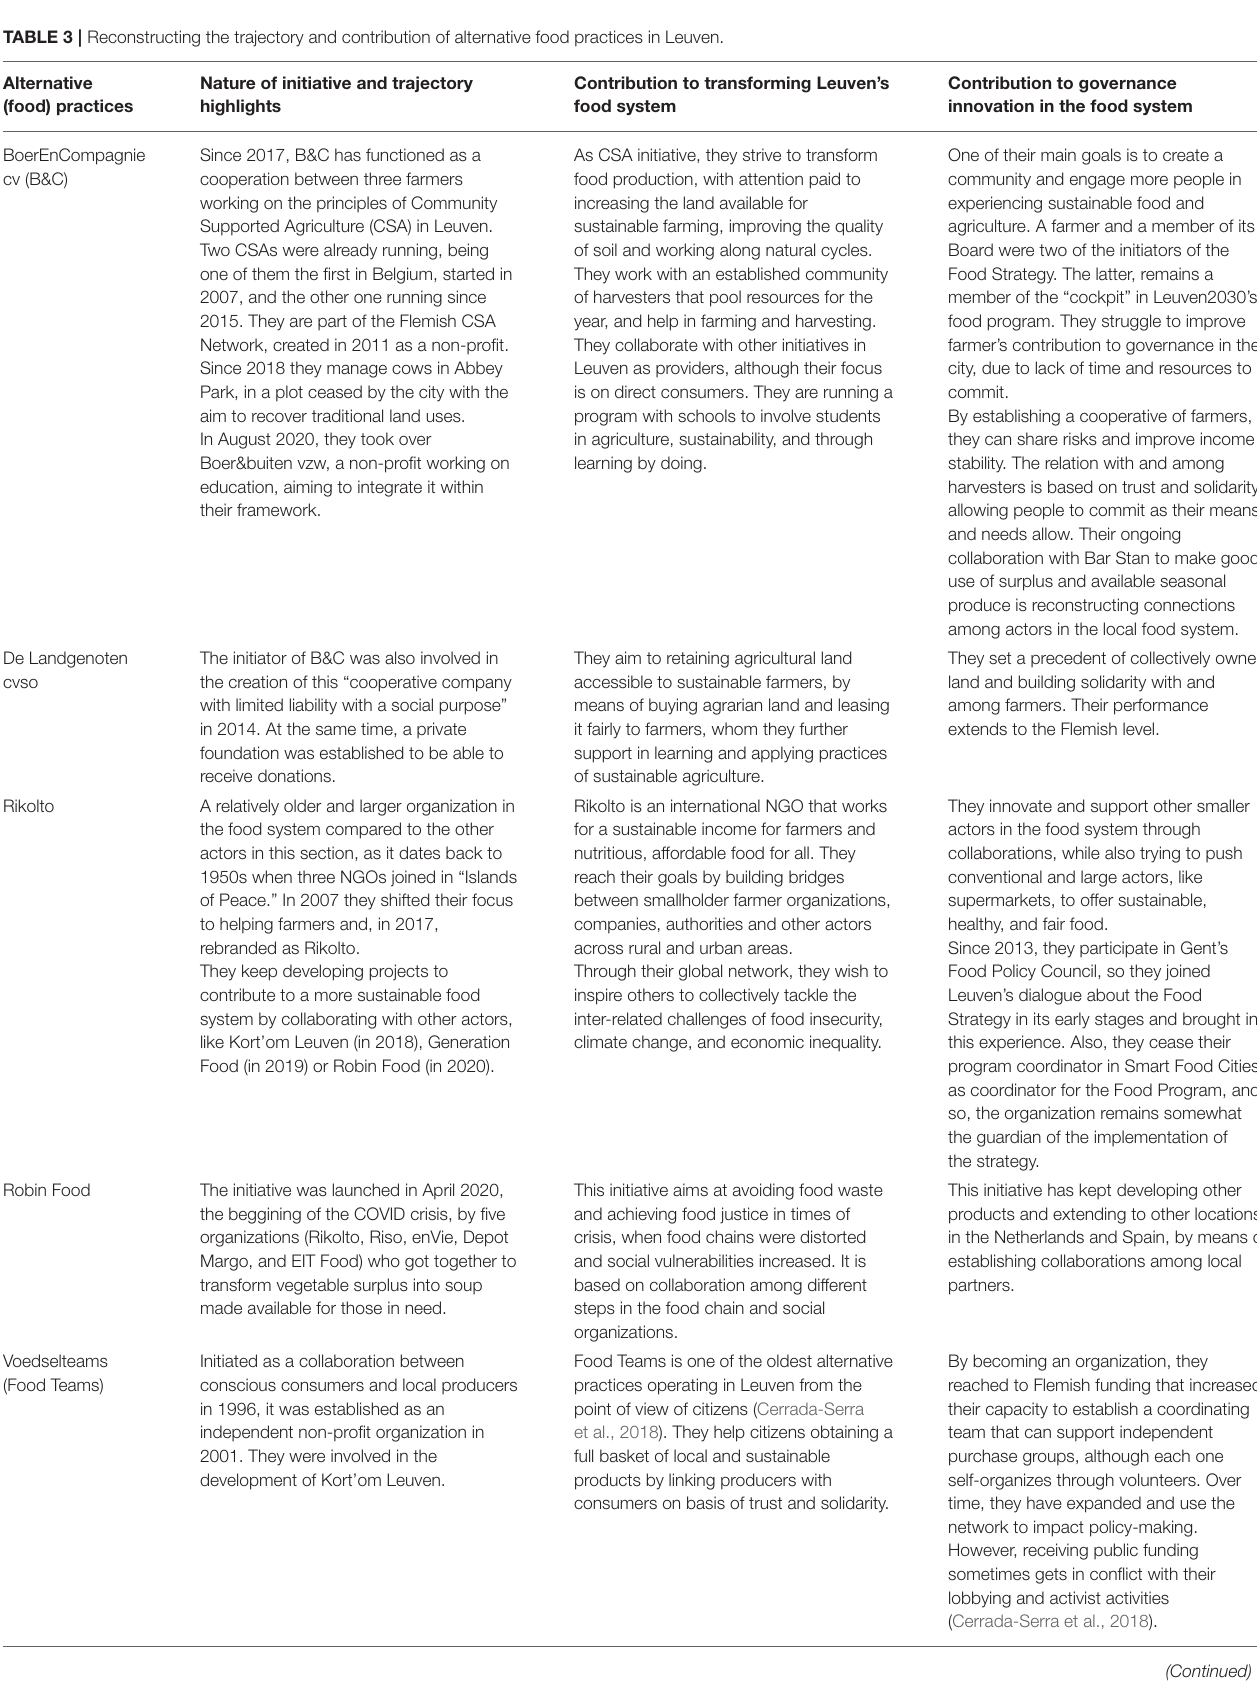
TABLE 3 | Reconstructing the trajectory and contribution of alternative food practices in Leuven. Alternative (food)